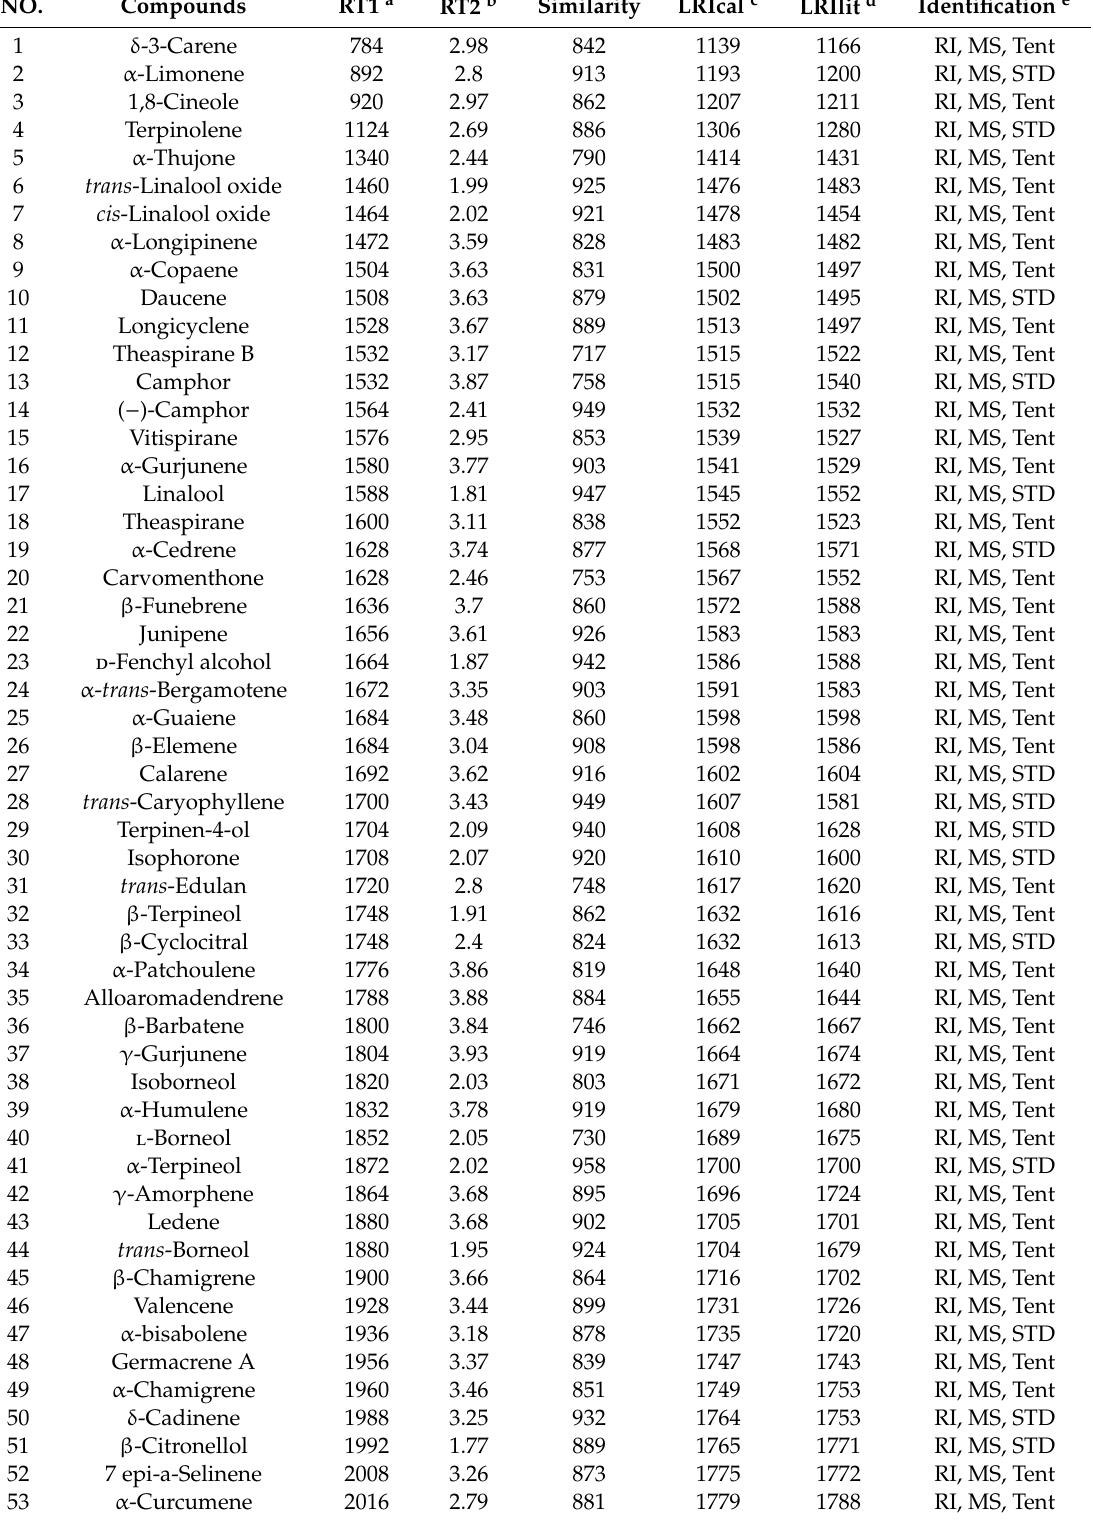
Table 2. A total of 82 terpene compounds in Chinese herbaceous aroma-type